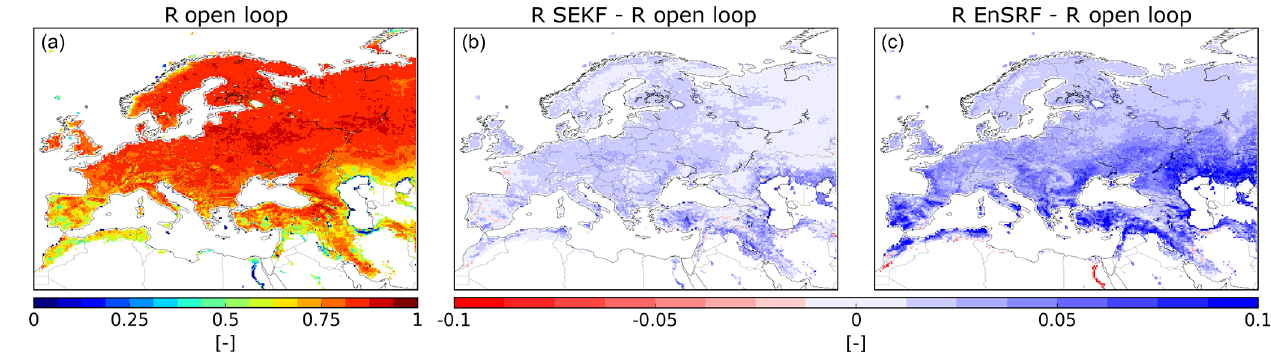
Figure 12. (a) Correlation ( R ) between observed GLEAM ET and its open-loop equivalent for the period 2008–2017 and R difference between assimilation experiments (SEKF in b and EnSRF in c ) and the open loop.